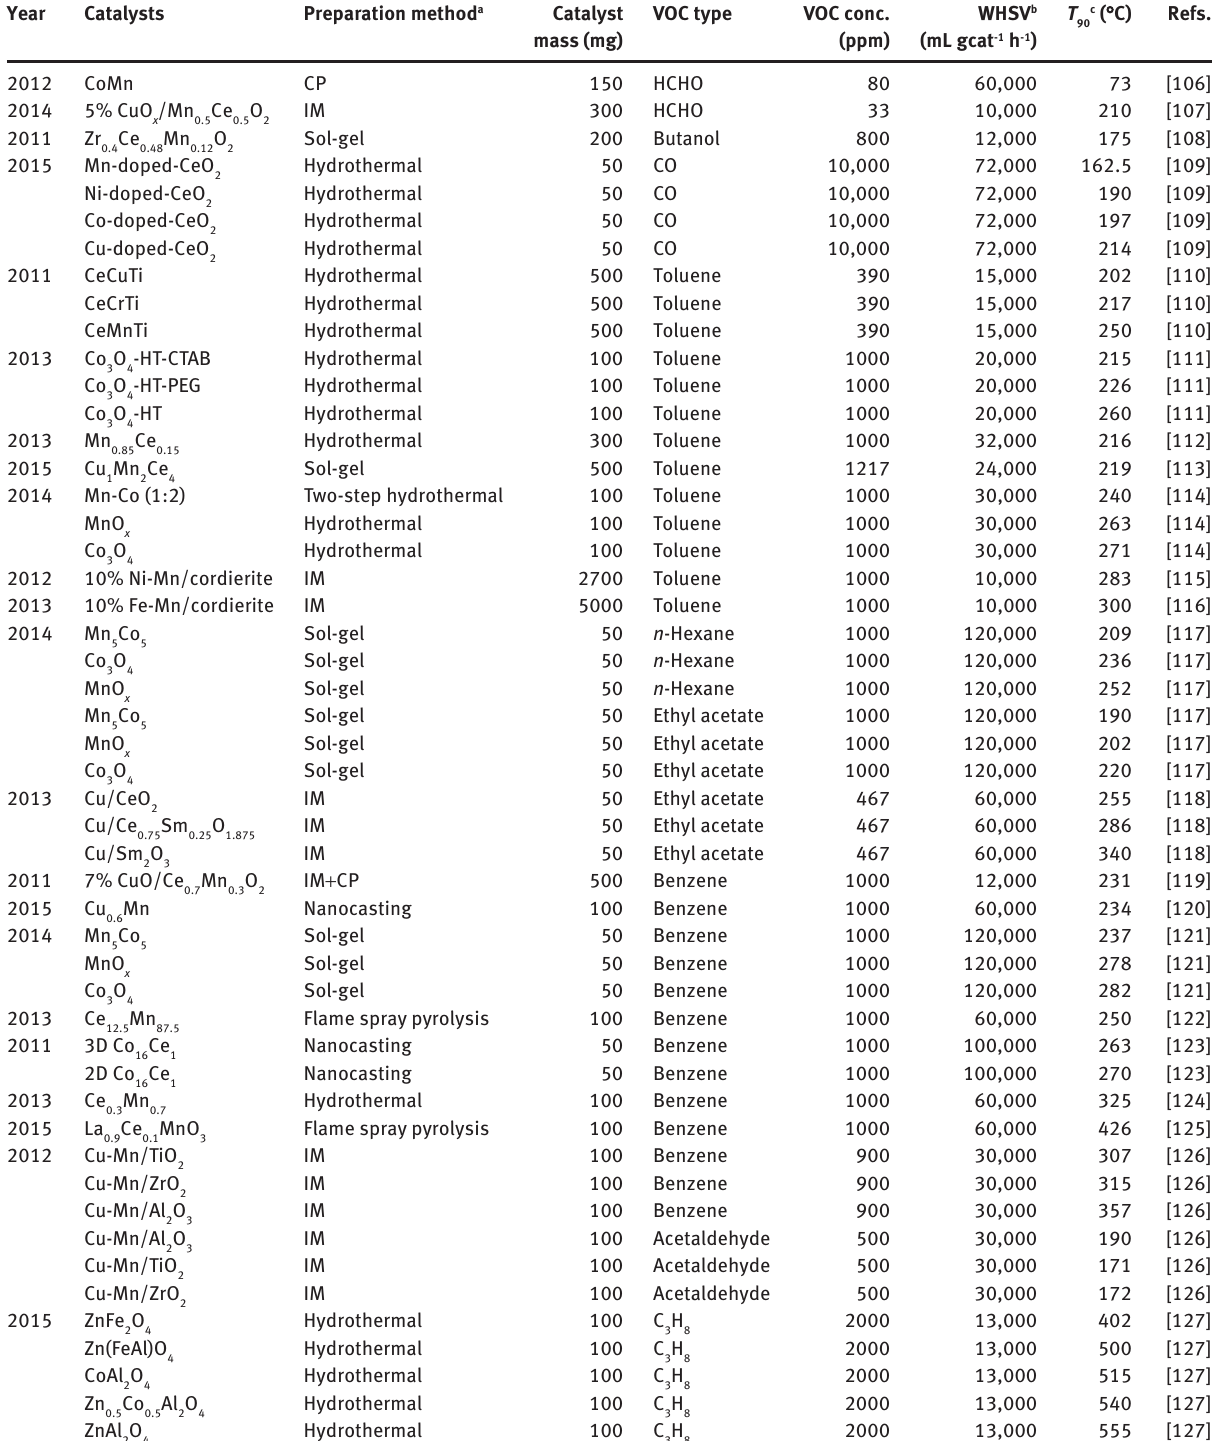
Table 2: Summary of publications in recent five years on metal oxide-based nanostructures for catalytic oxidation of